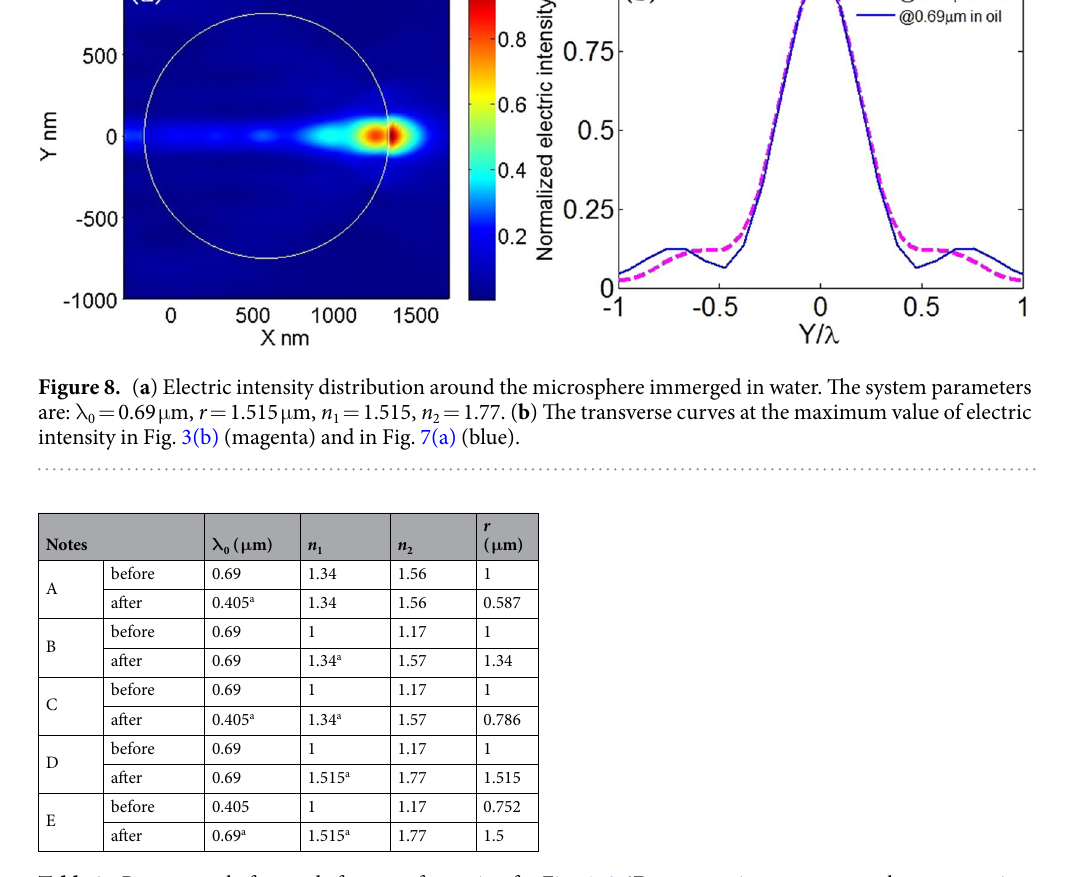
Table 2. Parameters before and after transformation for Figs 4–8. a Denotes active parameter, others are passive